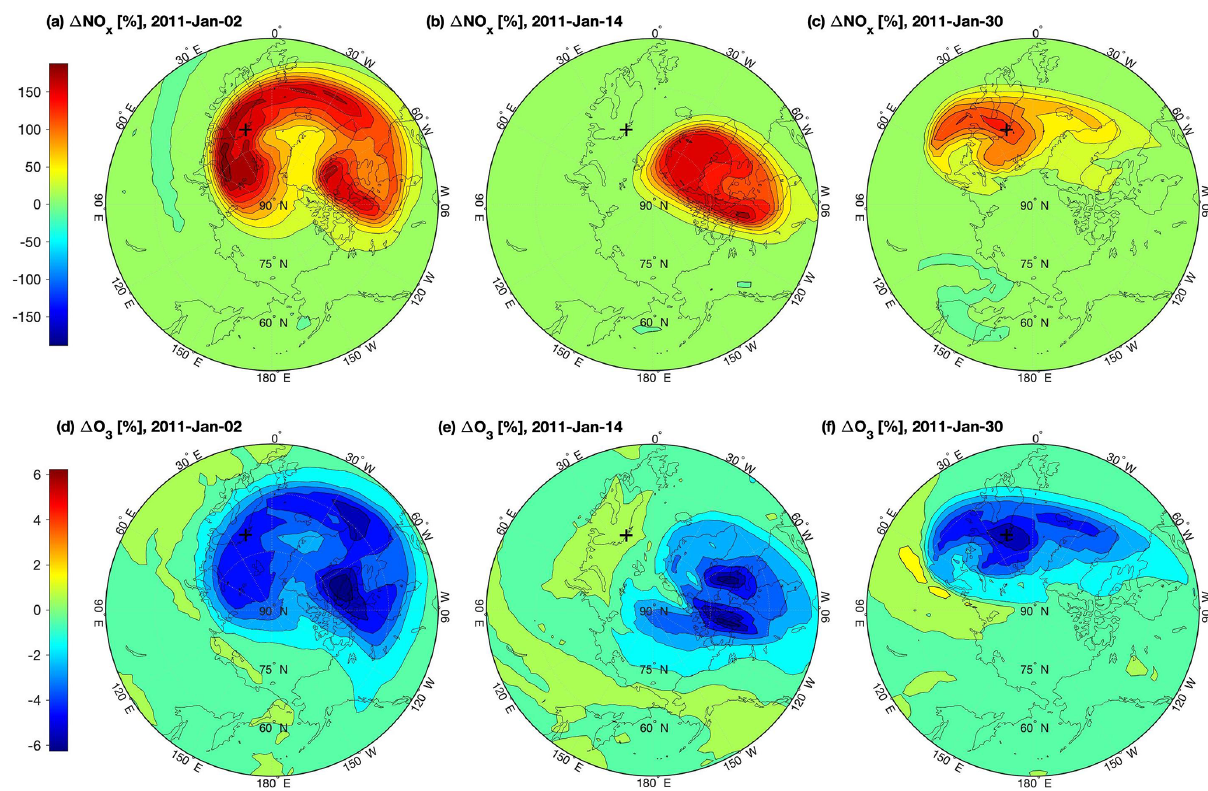
Figure 7. (a, b, c) Relative NO x differences between the full-PsA and no-PsA simulations at ∼ 40km altitude, at 12:00UT on (a) 2 Jan- uary 2011, (b) 14 January 2011, and (c) 30 January 2011. The black cross indicates the Tromsø station location. Latitudes from 45 to 90 ◦ N are displayed. (d, e, f) Same as the top row but for O 3